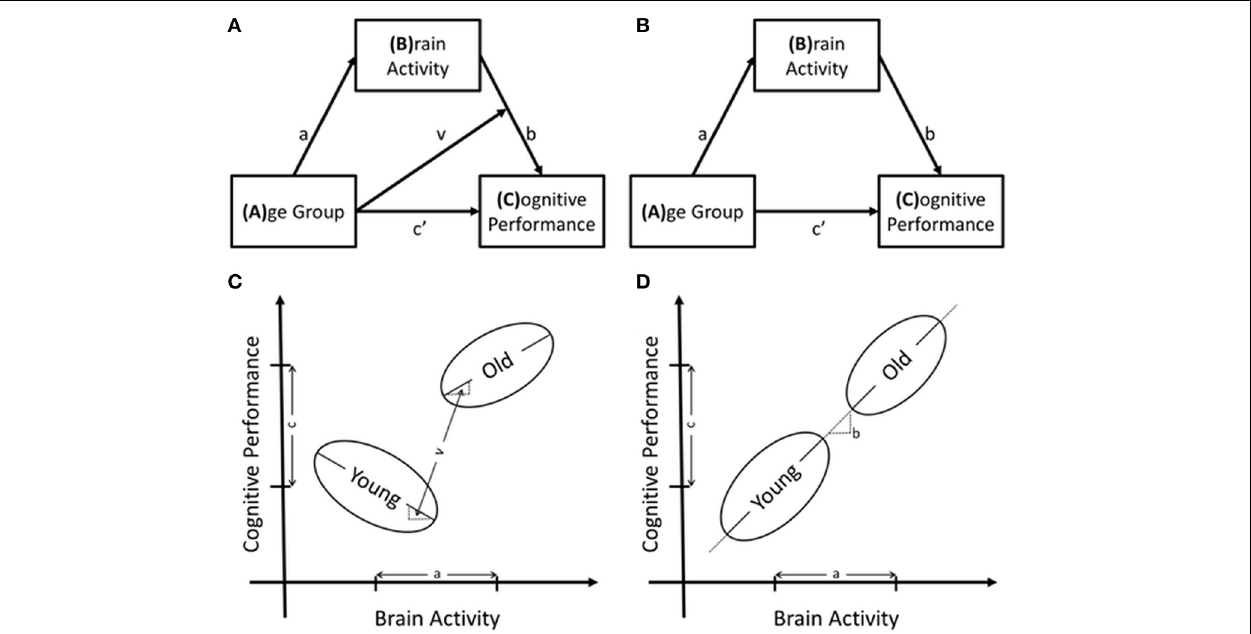
FIGURE 2 | Structural models of the relationships between age group, brain activity and cognitive performance as well as the potential results to support these models. In (A) is the moderated-mediation model that includes the interaction term and in (B) is the mediation model. Regression equations are derived from these models using any box with arrows pointing